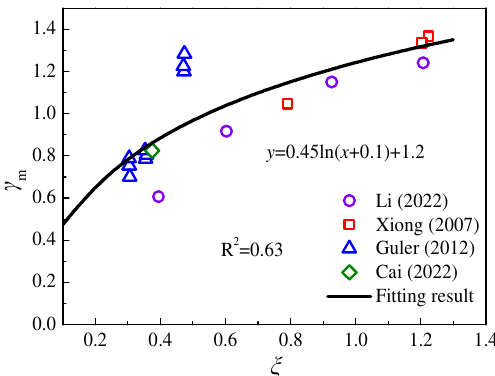
Figure 16. The relationship of γ m and ξ . (Guler et al. [37], Cai [38], Li et al. [42], Xiong et al. [43]).